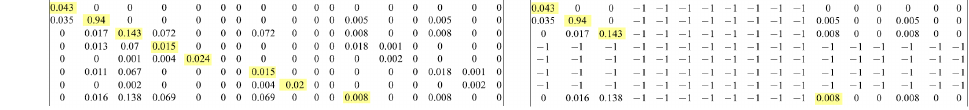
Figure A.3. The resulting scores matrix (left) and the updated scores matrix (right) after the application of